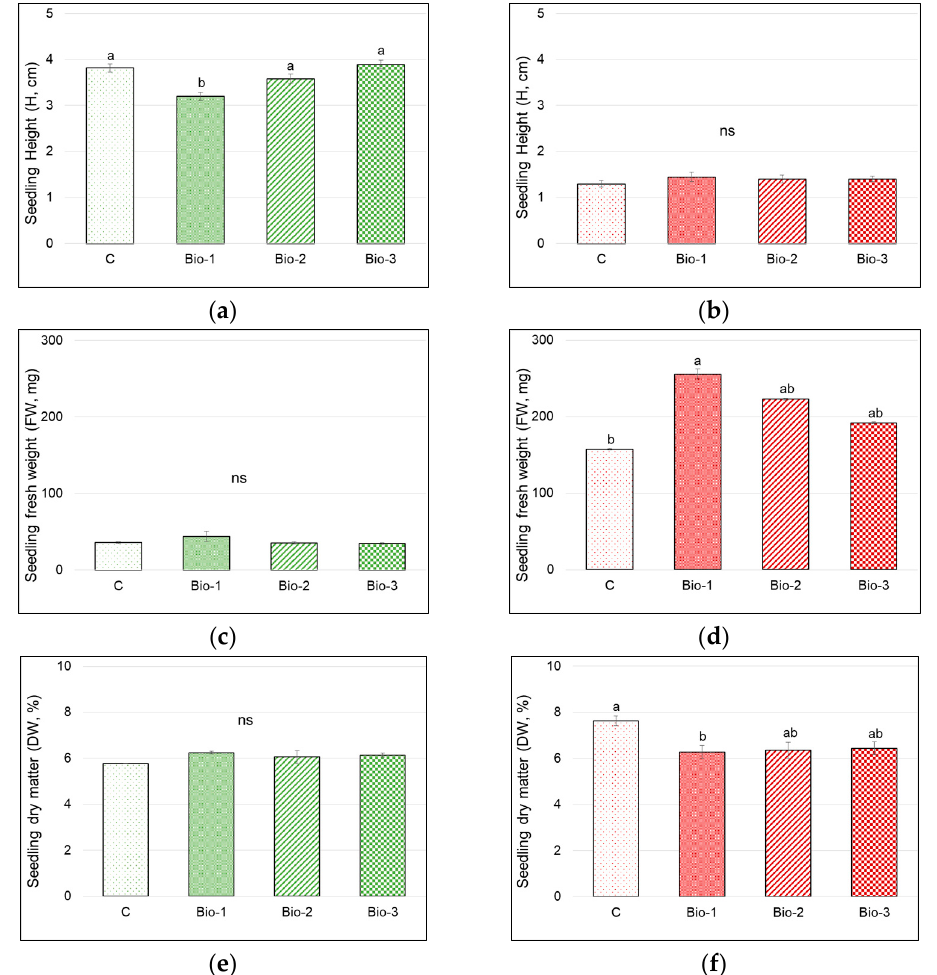
Figure 2. Effect of biostimulants (Bio-1 = TRAINER ® ; Bio-2 = AQUAMIN, and Bio-3 = Moringa oleifera leaf extract) on seedling height (cm), seedling fresh weight (mg), and dry weight percentage (%) in turnip greens ( a , c , e ) and radish ( b , d , f ) microgreens. Data are means ± se ( n = 3). Different letters indicate significance at p ≤ 0.05 according to LSD